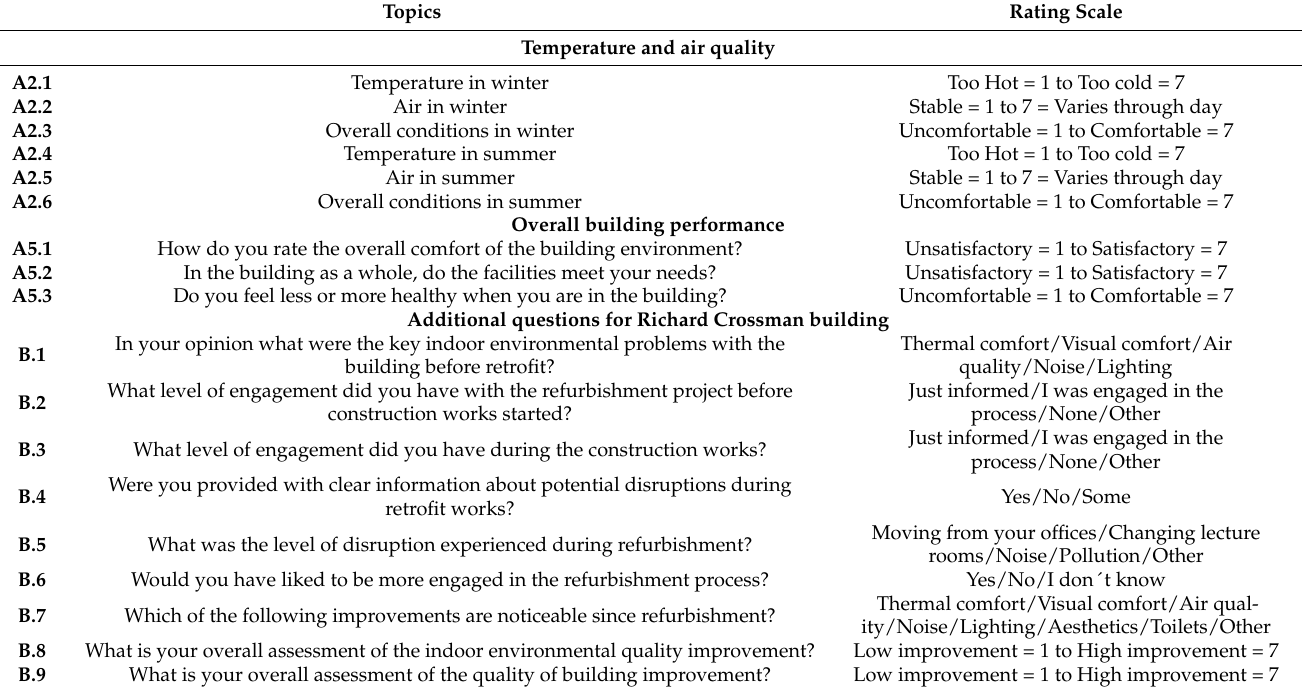
Table A1. Questions